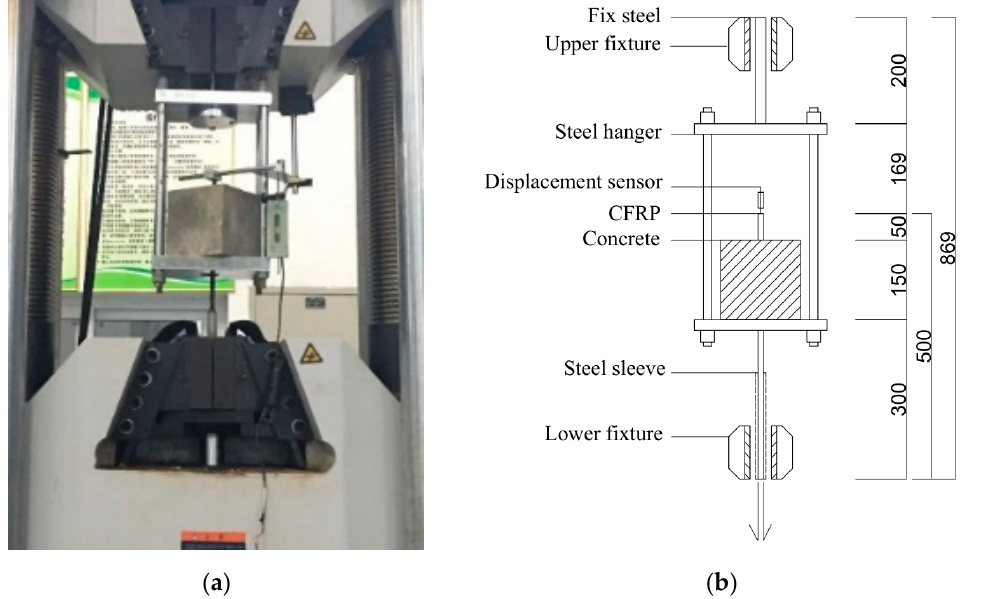
Figure 4. Experimental setup of pull-out test: ( a ) photograph; ( b ) illustration.